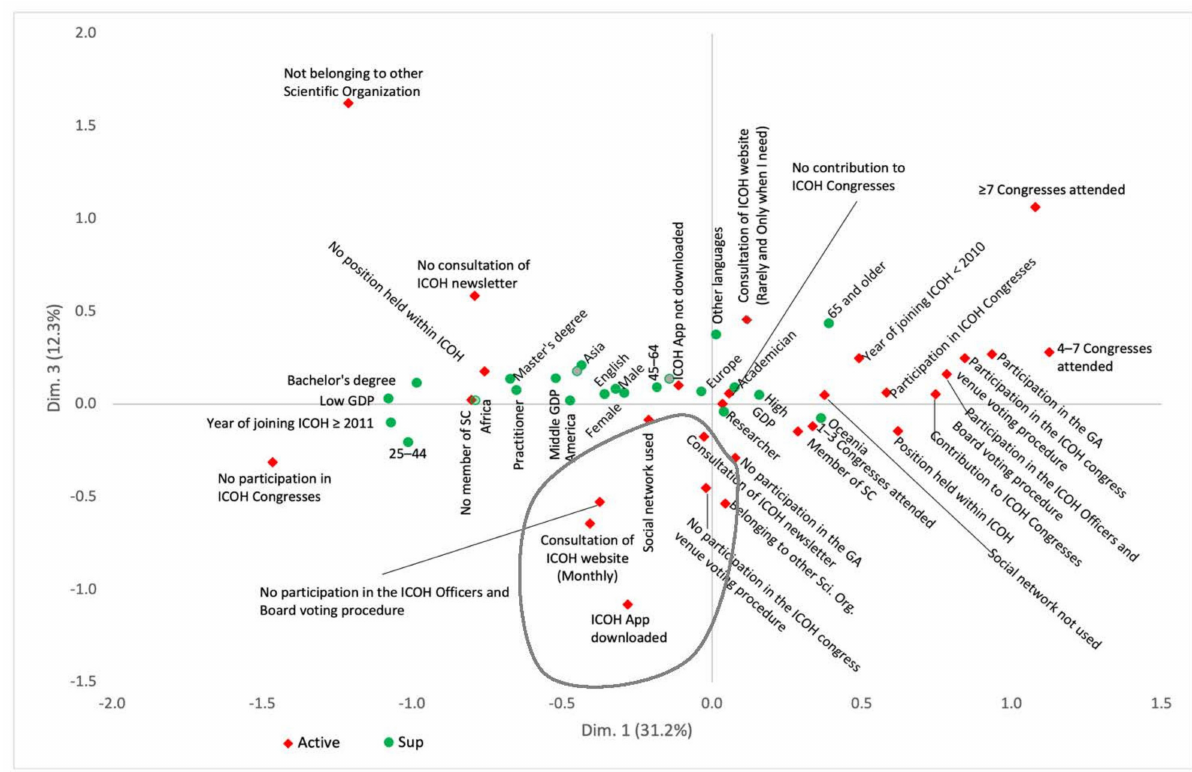
Figure 2. Multiple correspondence analysis map (projections on the first and third